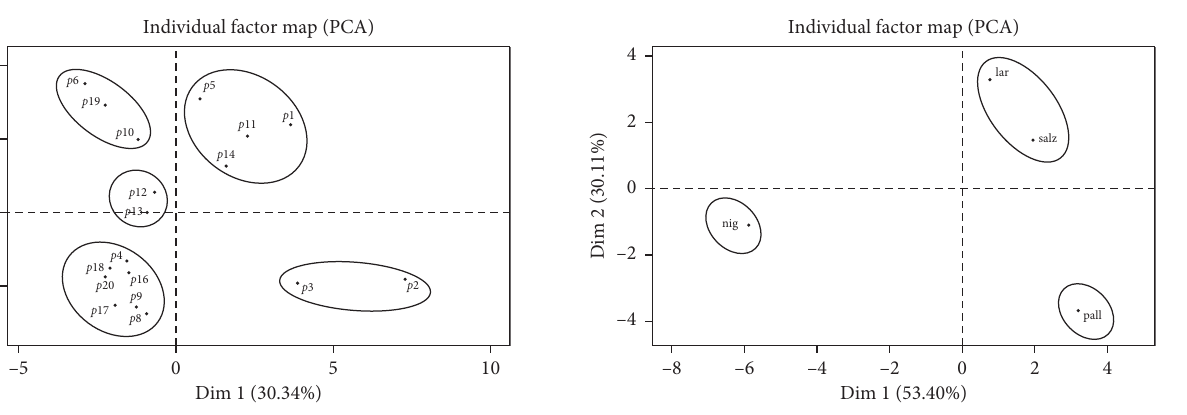
Figure 2: Individual factor map obtained from the PCA of data about the composition of Pinus nigra essential oils from 18 provenances.